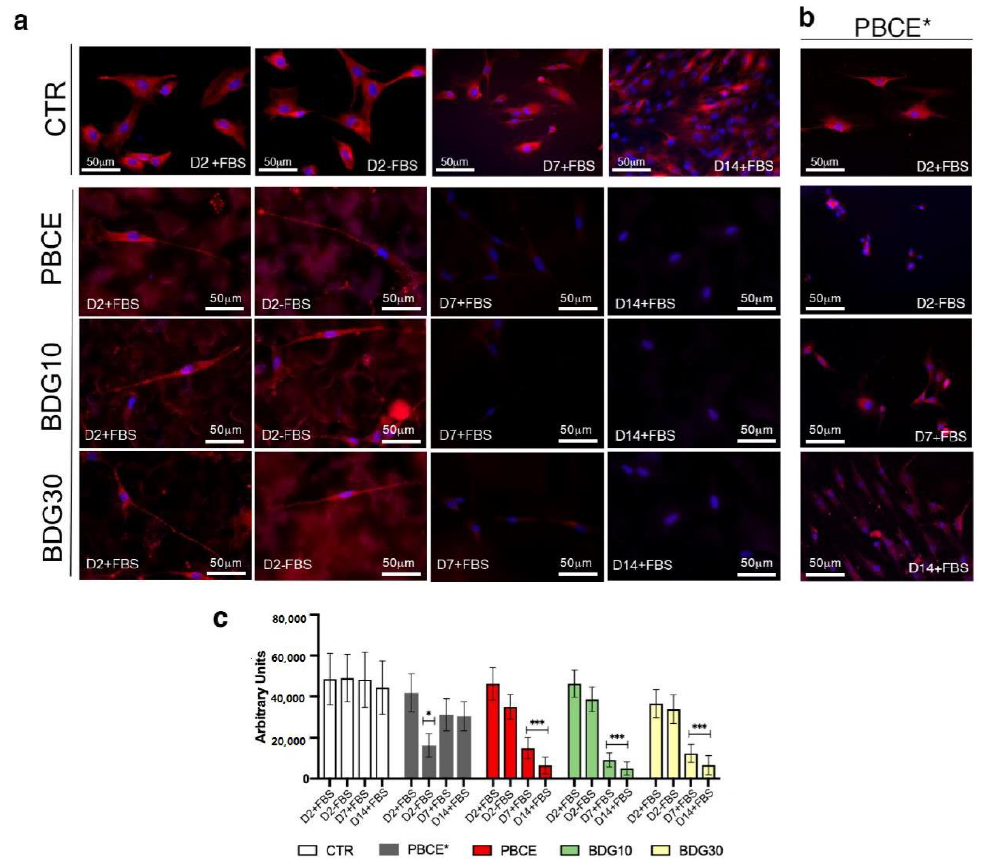
Figure 6. Expression of nestin in hBM-MSCs grown on PBCE*, PBCE, BDG10 and BDG30 . Representative fluorescence images revealed the expression of nestin in stem cells in ( a ) CTR cells, PBCE-, BDG10- and BDG30-polymer cultures at D2 (in the presence (+) and absence (-) of FBS), at D7 and D14 (in the presence (+) of FBS); ( b ) cells on PBCE* at D2 (in the presence (+) and absence (-) of FBS), at D7 and D14 (in the presence (+) of FBS). Nuclei (DAPI, blue), and nestin (human anti-nestin antibody, red). Scale bar 50 μm . (c) quantitative analysis of nestin expression in hBM-MSCs on PBCE*, PBCE, BDG10 and BDG30 a CTR at each time point. Data are expressed as mean SD, * p < 0.05, *** p < 0.005. For each experiment, an average of 100 cells for each culture condition was considered.